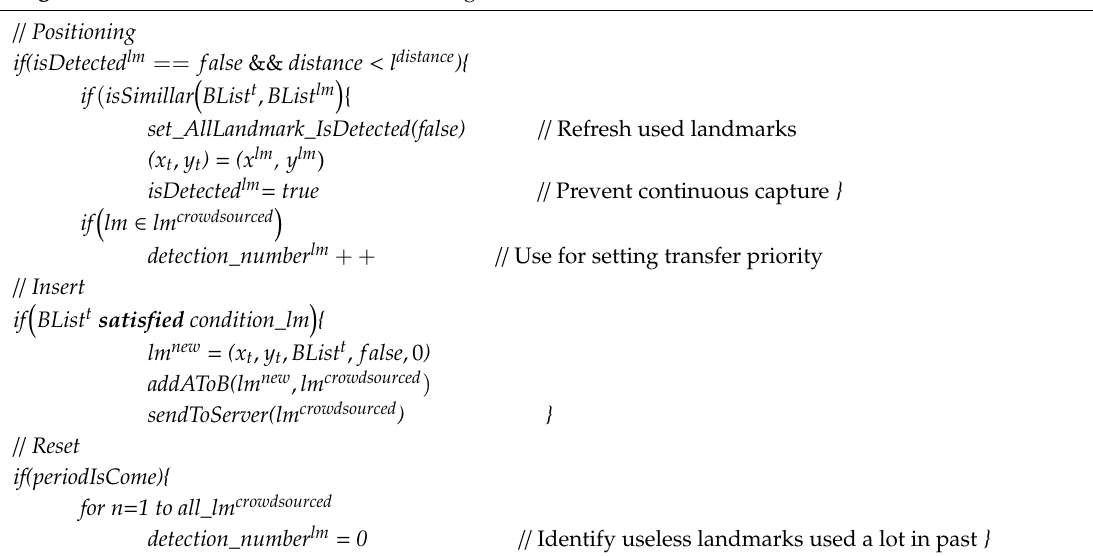
Algorithm 1. Pseudo code of the landmark